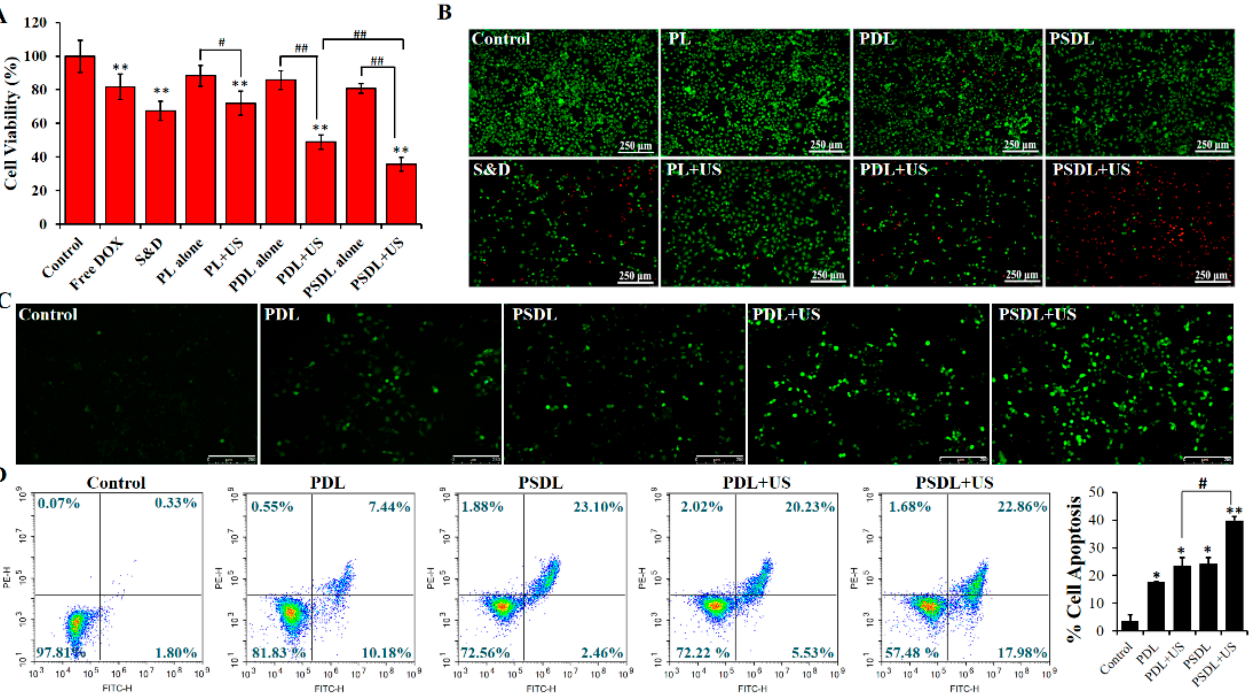
Figure 3. Cytotoxicity evaluation in vitro. ( A ) MDA-MB-231 cell viability after different treatments. (DOX = 1 μ g/mL, SRA737 = 0.5 μ g/mL; ultrasound: load power 2 W, duration 30 s; S&D: DOX+SRA737); ( B ) detection of MDA-MB-231 cell survival by calcein-AM/PI double staining; ( C ) intracellular ROS generation after different treatments using a fluorescence microscope (scale bar = 250 μ m); ( D ) cell apoptosis analysis via annexin V-PI combined with flow cytometry. * p < 0.05, ** p < 0.01, compared with control; # p < 0.05, ## p < 0.01 compared among groups.